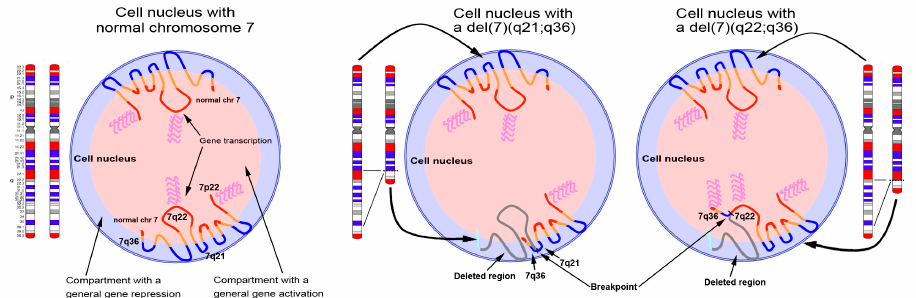
Figure 8. Distribution of chromosome 7 genomic material across the nucleus. The illustration depicts three nuclei with two normal copies of chromosome 7 ( left ), one chromosome 7 with an interstitial deletion involving the region included between 7q21 and 7q36 (middle), and one chromosome 7 with an interstitial deletion involving the region included between 7q22 and 7q36 ( right ). The representation of the chromosome 7 territories follows a zig-zag conformation of the DNA, according to data previously published [10]. Depending on the extent of the deletion, the terminal region of 7q, harboring HLXB9 , becomes juxtaposed to either the 7q21 band or the 7q22 bands. The vicinity to the 7q21 band, positioned at the periphery of the nucleus, determines a peripheral position for HLXB9 , whereas the vicinity to the 7q22 band, normally positioned towards the inner part of the nucleus, causes an alteration in the location of HLXB9 , which becomes positioned more internally. Since the repositioning potentially alters the gene expression pattern of the affected gene, this could explain the ectopic activation of HLXB9 allele repositioned in the inner part of the nucleus. Red and blue chromosomal bands correspond to the GC-richest and the GC-poorest bands in the chromosome 7 [10].